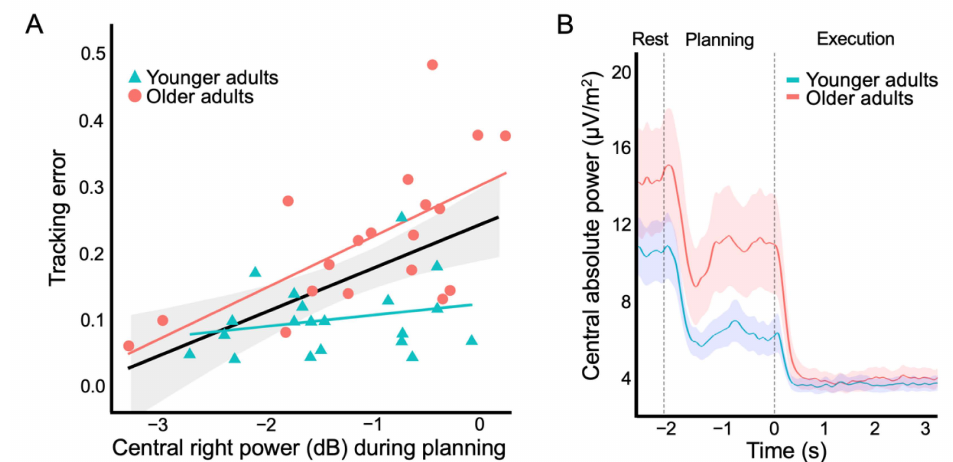
Figure 7. Functional role of movement-related beta desynchronization (MRBD). ( A ). Correlation between central right motor planning MRBD and tracking error. Better performance (lower error) is associated with higher MRBD. The black line shows the average correlation ( ρ = 0.49, p = 0.002), the blue and red lines show the correlations for younger ( ρ = 0.14, p = 0.551) and older adults ( ρ = 0.56, p = 0.014). ( B ). Absolute central power (post-Laplacian transformation), during the bimanual tracking task (BTT). This figure aids mechanistic understanding of MRBD. Here, MRBD is the reduction